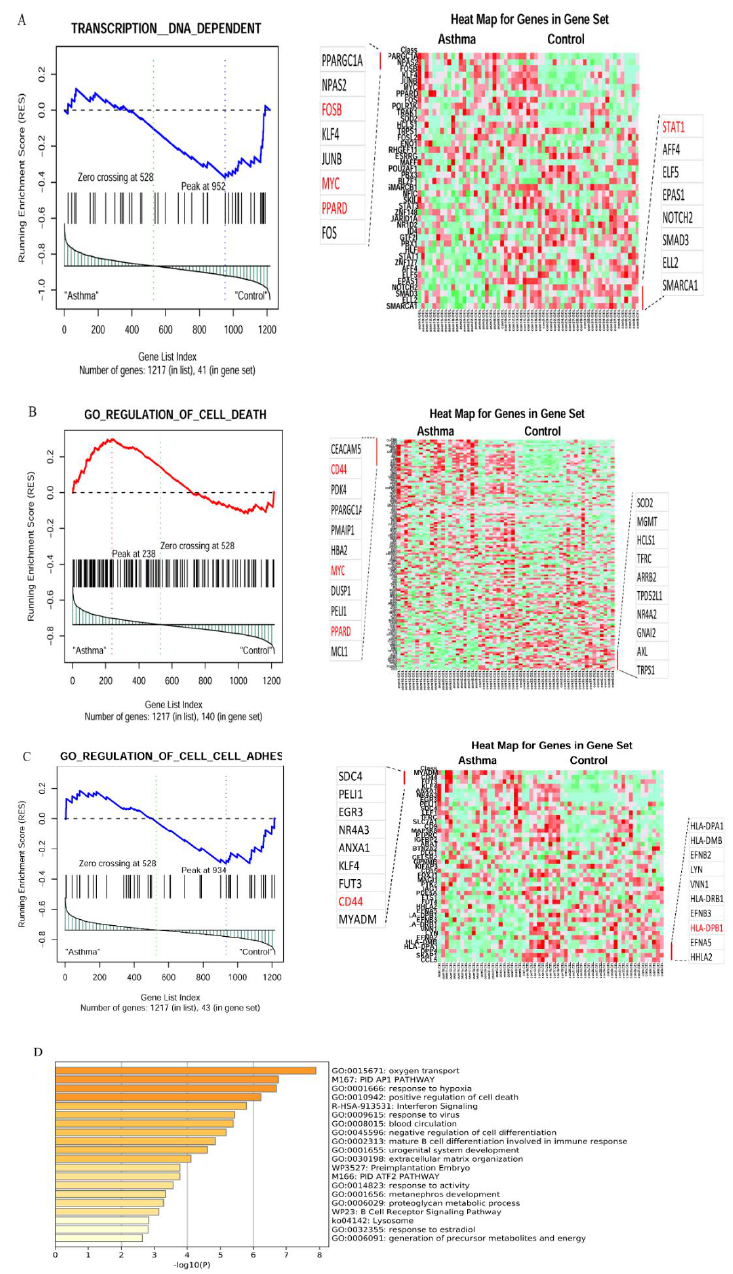
Figure 4. Gene set enrichment analysis (GSEA) of the differentially expressed genes between severe asthmatic bronchial epithelium ( n = 23) and healthy bronchial epithelium ( n = 37) in GSE64913. ( A ) DNA transcription, ( B ) regulation of cell death, ( C ) regulation of cell adhesion (left panel shows the distribution of DNA transcription, regulation of cell death, and cell adhesion target genes according to their rank position. The right panel shows a heatmap illustration of their expression between asthmatic and healthy control). ( D ) The top enriched pathways whether upregulated or downregulated in severe asthma compared to healthy controls using metascape (http://metascape. org last access date 15 January 2022): a gene annotation and analysis online resource that generates a graphical